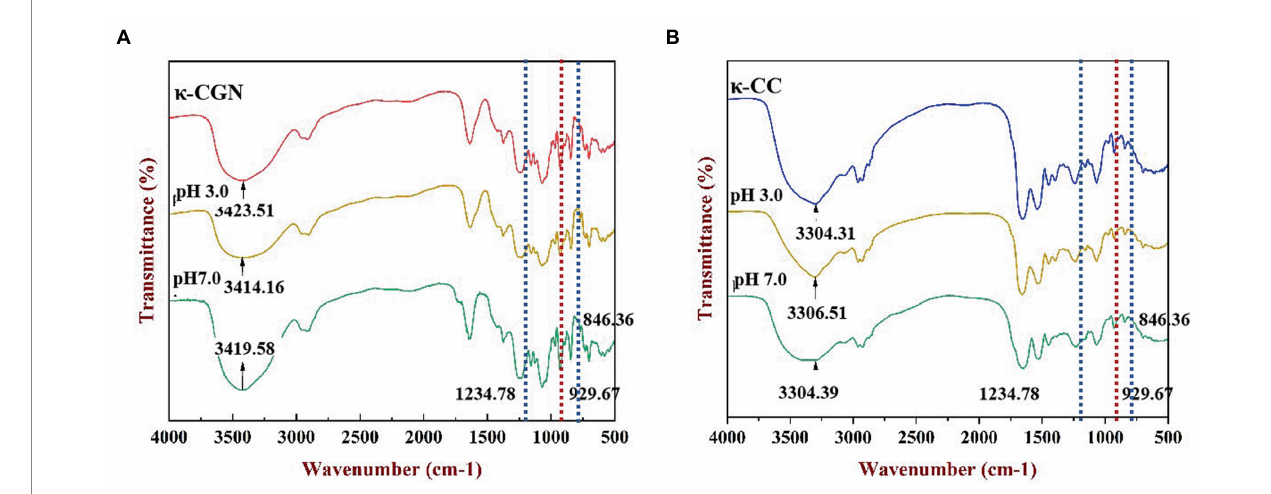
FIGURE 2 FT-IR spectra of the κ -CGN (A) and κ -CC (B) at physiological pH in the simulated gastrointestinal